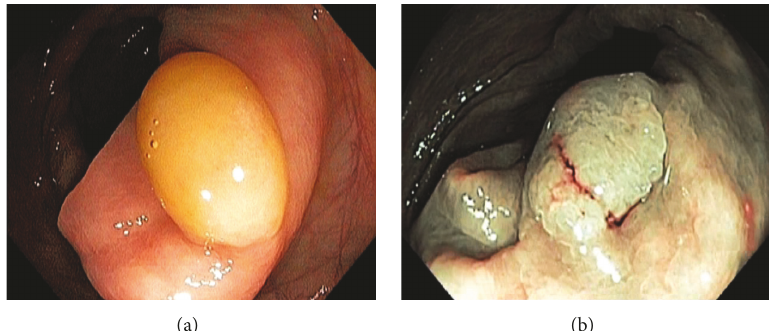
Figure 37: Endoscopic image of a serrated sessile adenoma: the adenoma is covered by a mucus cap or mucoid covering (a); after the mucus cap is washed off, the adenoma is examined under digital chromoendoscopy (b).